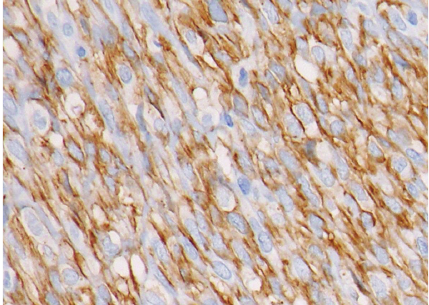
Figure 5: Common CD31 positivity in tumoral cells (original mag- nification, H&E × 100).